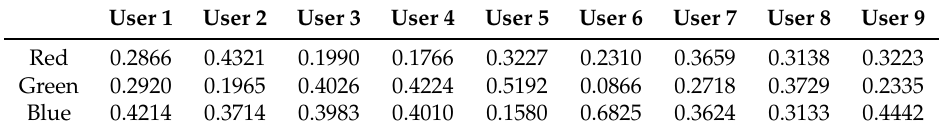
Table 1. Patterns of users in a simple demonstration. The values correspond to the figures in Figure 9.